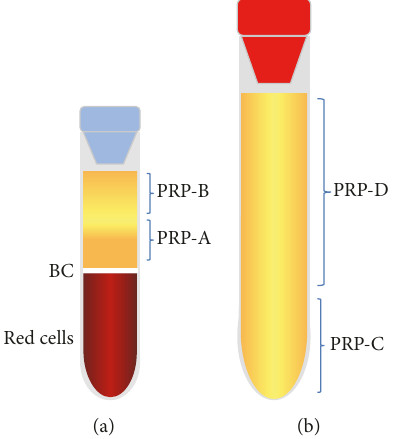
Figure 1: Schematic representation of the four platelet-rich plasma (PRP) fractions obtained with the single (A and B) and double (C and D) centrifugation tube methods. (a) Sodium citrate tube containing whole blood. After centrifugation, whole blood was separated in several components: red cells (PCV), buffy coat (BC), and the PRP-A (50%) and PRP-B (50%) fractions. (b) A 10mL sterile plastic tube containing PRP-A. After centrifugation, this hemoderivative was divided into PRP-C (25%) and PRP-D (75%)